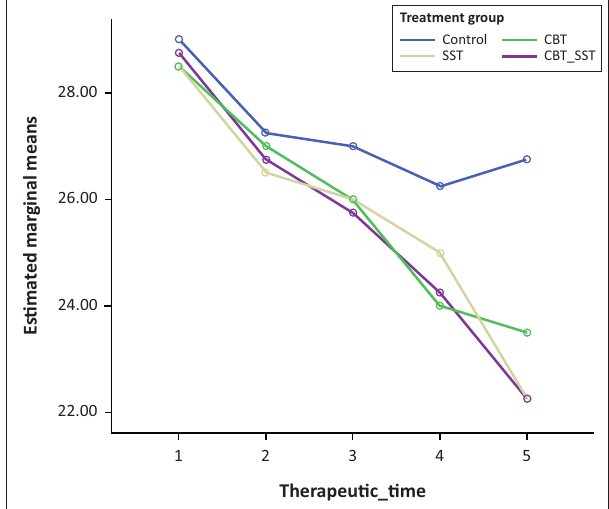
FIGURE 1: The efficacy of the behavioural interventions (CBT, SST and CBT+SST) on conduct